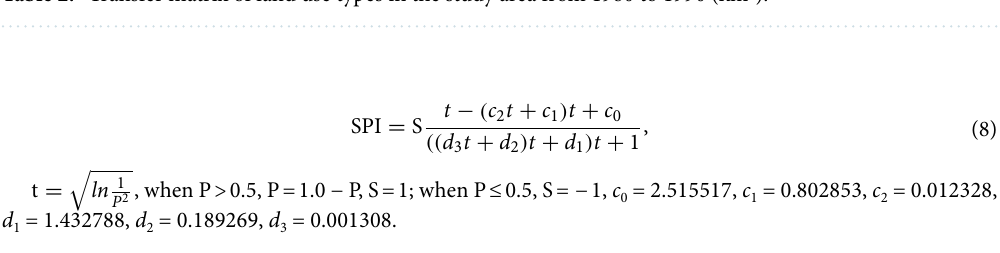
Table 2. Transfer matrix of land use types in the study area from 1980 to 1990 (km 2